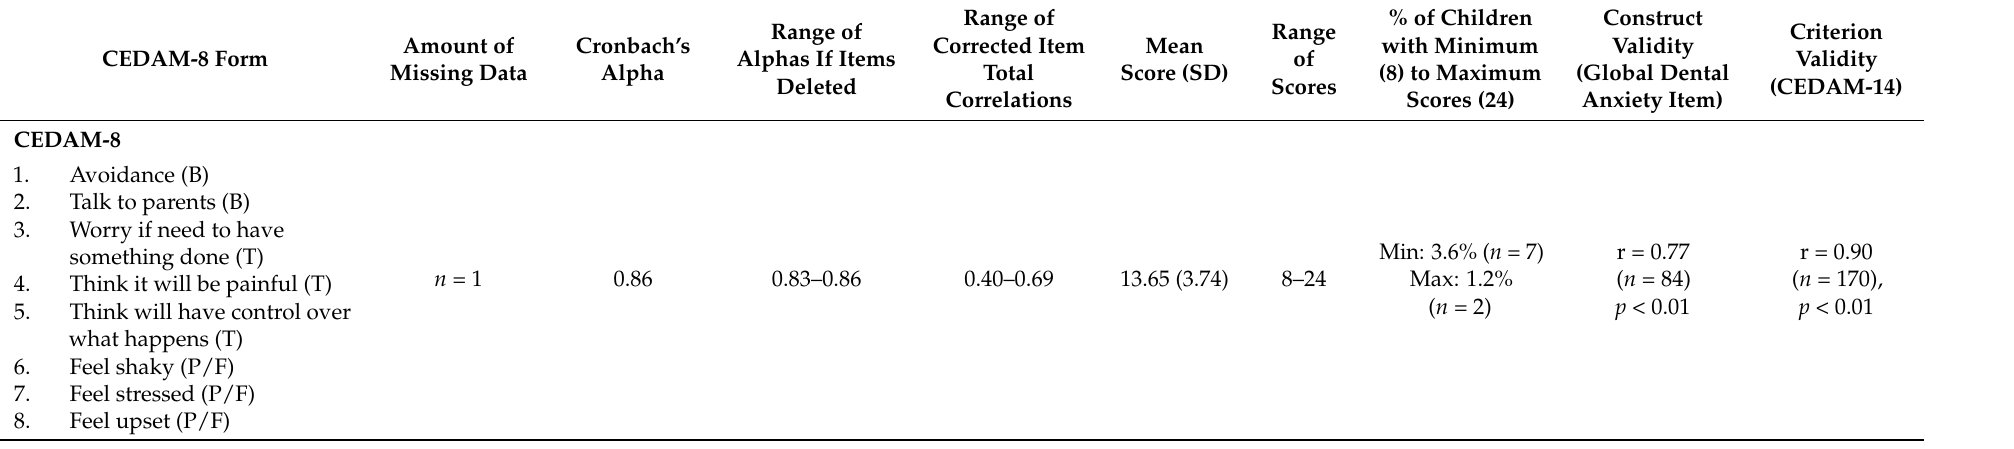
Table 2. Psychometric properties of the CEDAM-8 (data set 2, n =